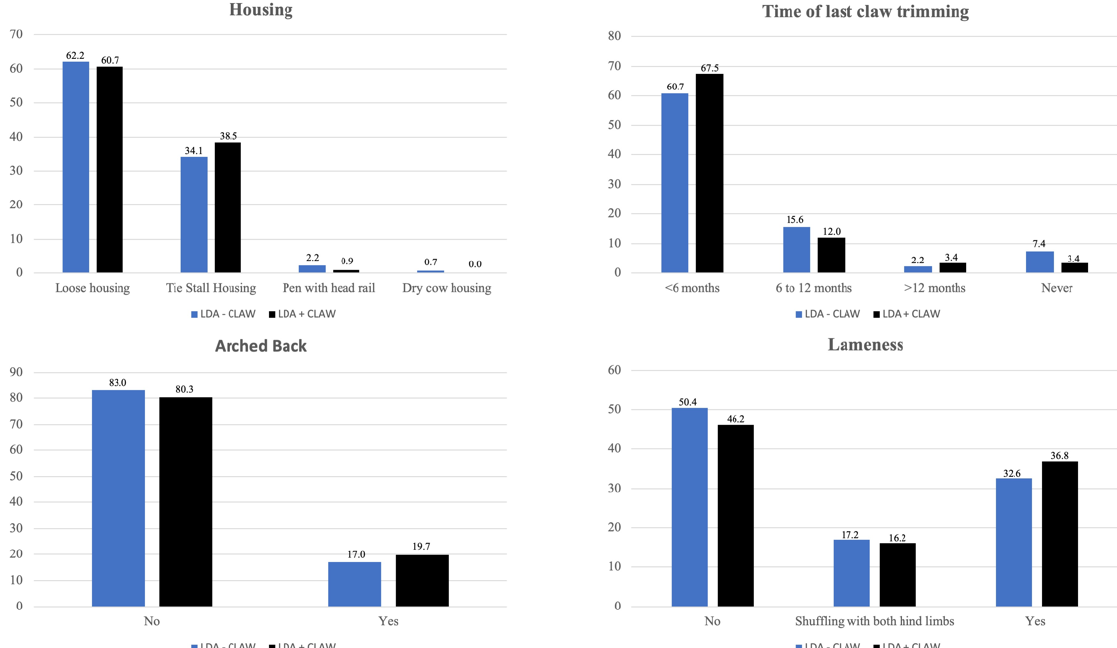
Figure 3. Housing, time of last claw trimming, and occurrence of arched back and lameness in 135 cattle diagnosed with left displaced abomasum without claw lesion (LDA − CLAW, blue), and 117 cattle diagnosed with left displaced abomasum and at least one claw lesion (LDA + CLAW, black). Number of cattle is given as %. Data missing for housing ( n = 1 for LDA − CLAW) and for time of last claw trimming ( n = 19 for LDA − CLAW and n = 35 for LDA + CLAW, respectively) is not presented as bars. Table 5. Distribution of occurrence of lameness and an arched back in cattle diagnosed with left displacement of the abo- masum and no claw lesion (LDA − CLAW) or at least one claw lesion (LDA + CLAW). ‘Shuffling’ was defined as shuffling with both hind limbs. Results with a p -value < 0.05 were considered statistically significant. Significant differences < 0.01 are indicated as **.